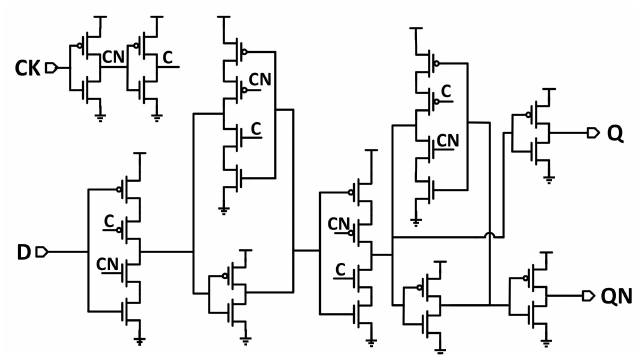
Figure 1. Schematic of master–slave